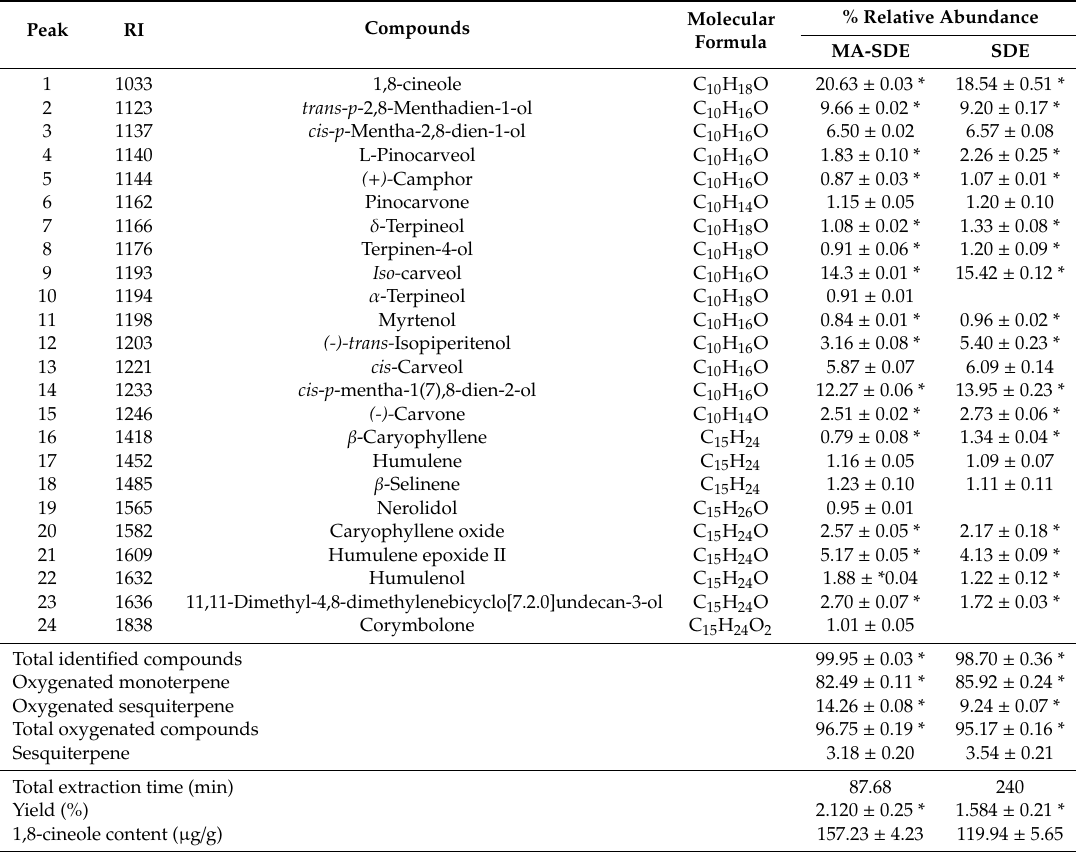
Table 2. Identified compositions of essential oil from Siam cardamom by GC–MS analysis.